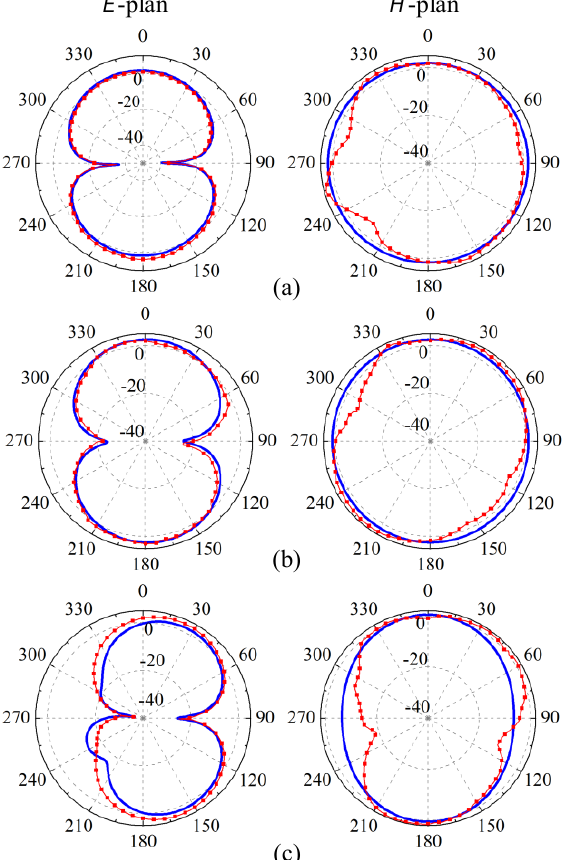
Figure 12: Measured (dashed line) and simulated (solid line) radiation patterns of the proposed antenna in H- plane and E-plane at (a) 2.4 GHz, (b) 3.6 GHz, and (c) 5.8